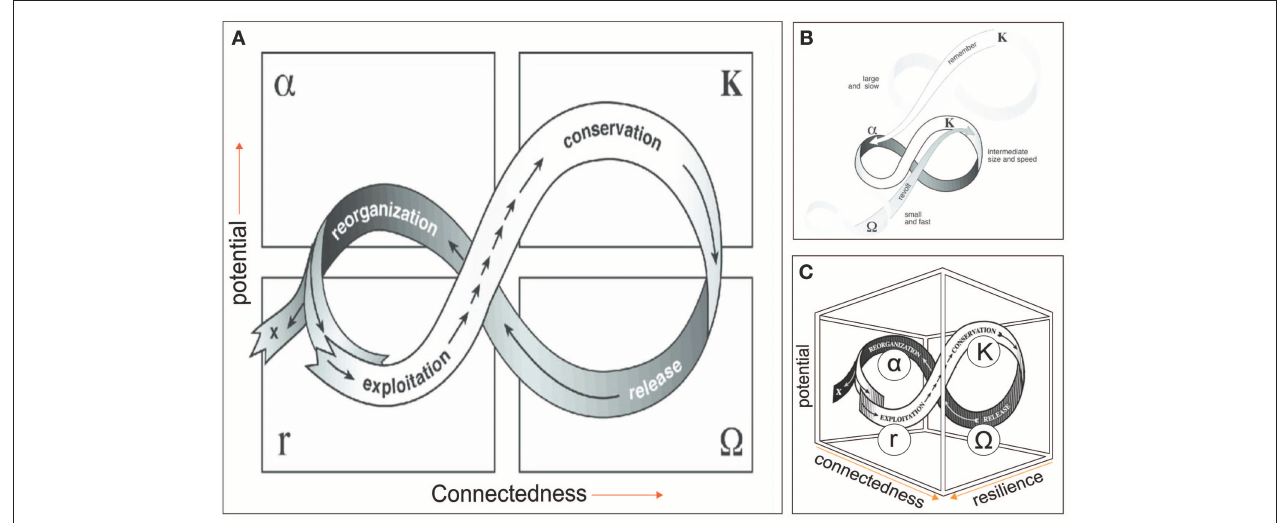
FIGURE 2 | (A) Adaptive cycle. (B) Panarchy. Cross-scale linkages among adaptive cycles in a social-ecological system, in which successively smaller, faster cycles are embedded in larger, slower ones. (C) Three dimensional representation of the adaptive cycle. Potential represents resources in the form of stored capital available to effect change, which may include knowledge and financial, social, and natural capital; Connectedness refers to the flexibility or rigidity of controlling variables or processes in response to external variation; Resilience is the capacity of the system to absorb or withstand perturbations and other stressors such that it maintains its structure and functions [i.e., does not undergo regime change. Adapted from Gunderson and Holling (